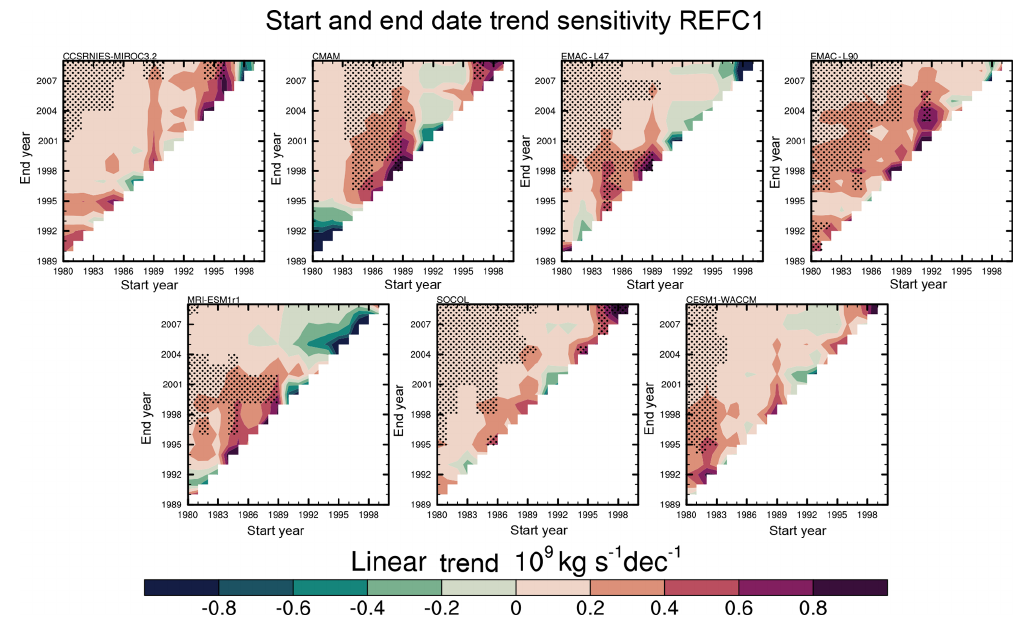
Figure 12. Tropical upward mass flux trends at 70hPa ( × 10 9 kgs − 1 decade − 1 ) for different start (abscissa) and end (ordinate) dates over the period 1980–2009 for the REF-C1 (r1i1p1) simulations. Trends are not shown for periods of less than 10 years. Values with statistical significance greater than the 95% level are shaded.